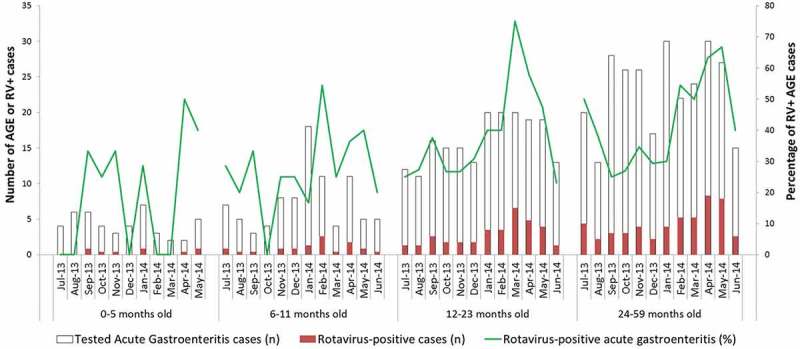
Seasonal distribution of acute gastroenteritis (AGE) cases and percentage of rotavirus-positive (RV+) cases by age group (months).